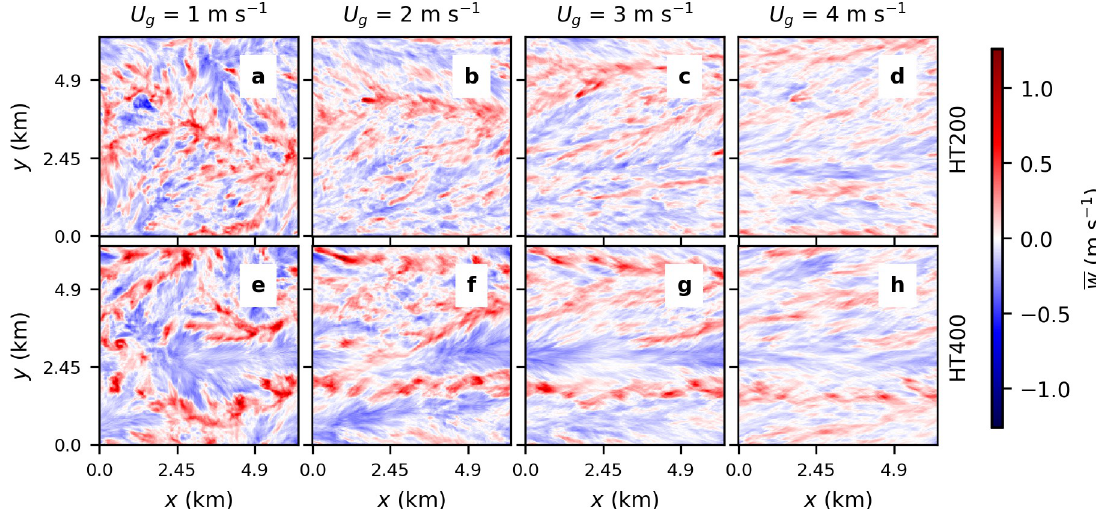
Fig 5. Exemplary horizontal cross-sections of the half-hourly averaged vertical wind speed w at 0.04 z simulations with U g up to 4 m s -1